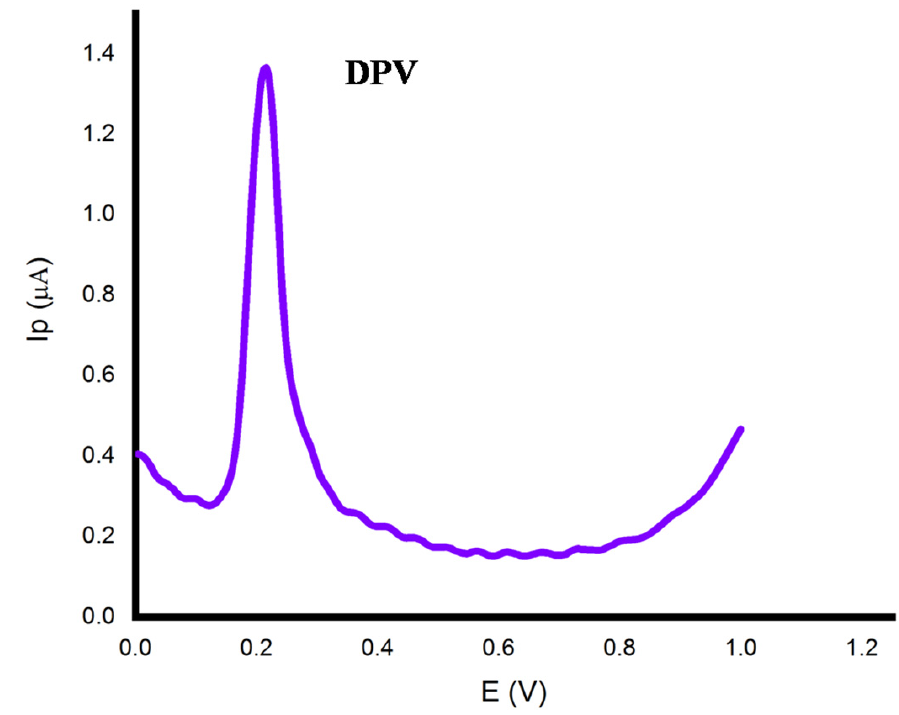
Figure 8. Differential pulse voltammogram of modified Xanthan gum nanoparticle electrode for Hg 2+ ions.